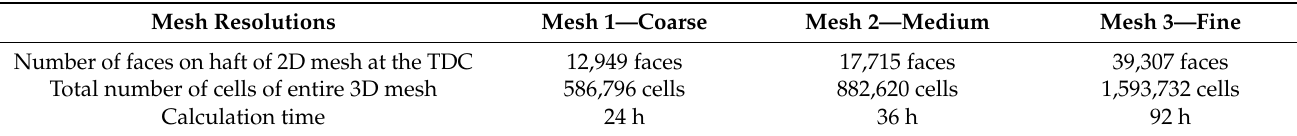
Table 5. The properties of meshes and the calculation time.